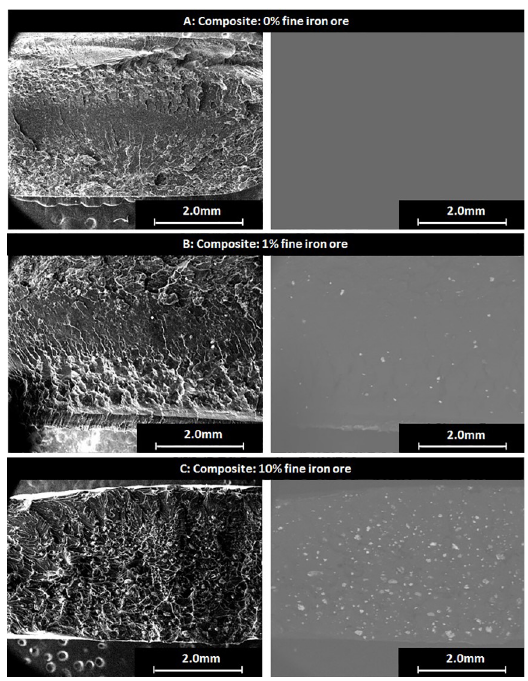
Figure 11. SEM and BSE images of fractured surfaces of composites before UV exposure. EDS mapping in Figure 12 also confirmed that iron ore fines were well distributed in the polymeric matrix. A colour map of EDS is assigned for each element, having the colours red, green, blue and yellow for C, O, Si and Fe, respectively. The EDS maps show more intense red colour (C) in regions of polymer domain, and increased distribution of green colour (O) is present in regions with hematite and quartz particles.